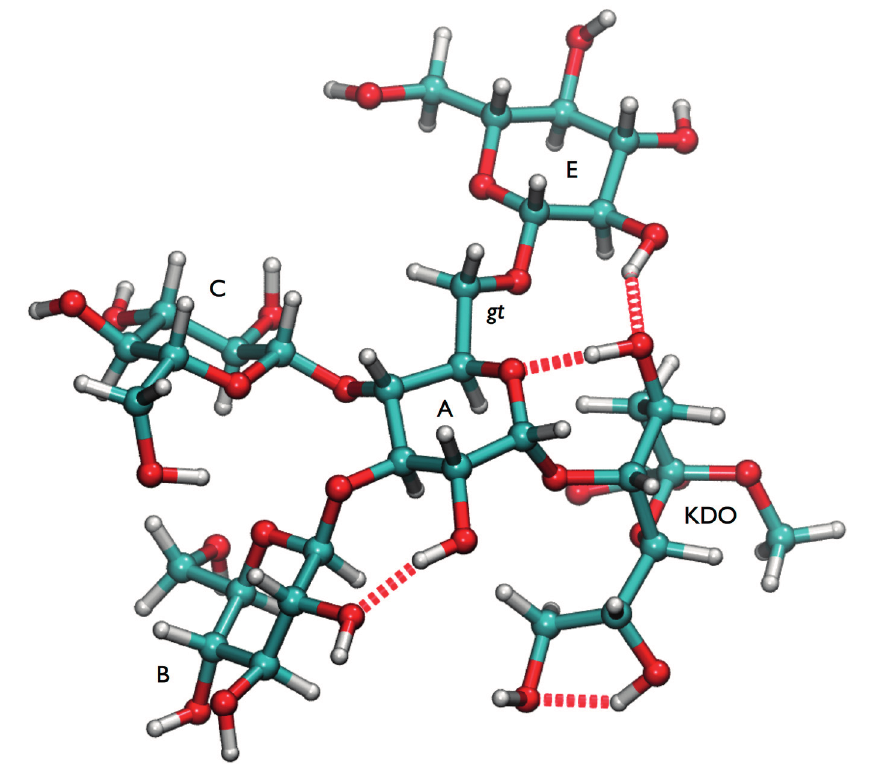
Figure 4. Global minimum conformation of lgt1/4 Δ